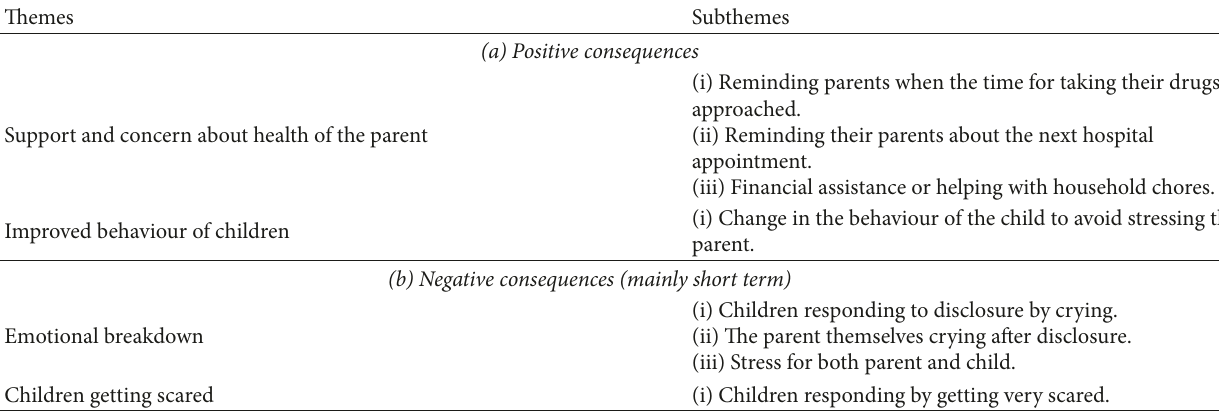
Table 5: Consequences of disclosure, as presented by parents that had disclosed their HIV status. Themes